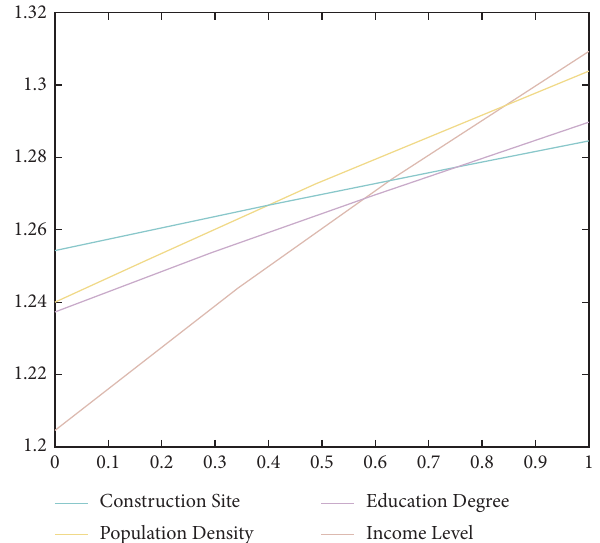
Figure 9: Relationship between basic regeneration number R